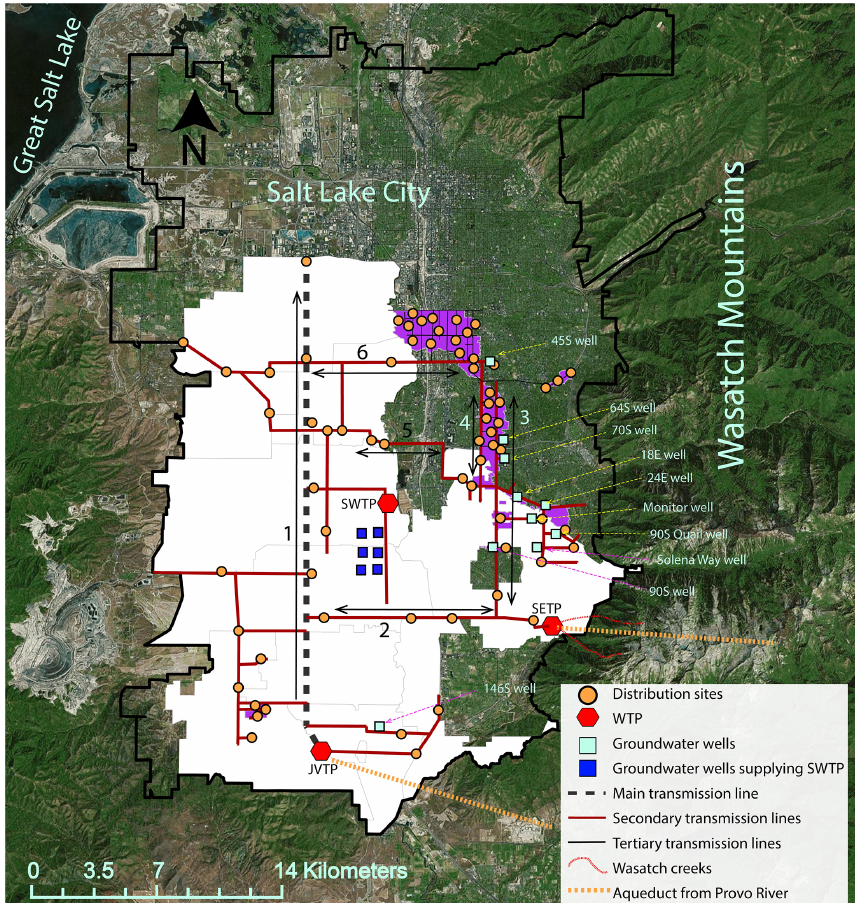
Figure 1. Jordan Valley Water Conservancy District (JVD) wholesale area (white) and Jordan Valley retail area (purple) within the Salt Lake metropolitan valley (black border). Water from wells shown in light blue color is pumped directly into the transmission lines on which they are located. The aqueducts from the Provo River and the Wasatch creeks are shown for illustrative purposes only. WTP: water treatment plant, JVTP: Jordan Valley Water Treatment Plant, SETP: Southeast Water Treatment Plant, SWTP: Southwest Water Treatment Plant. Source of base map: ESRI digital